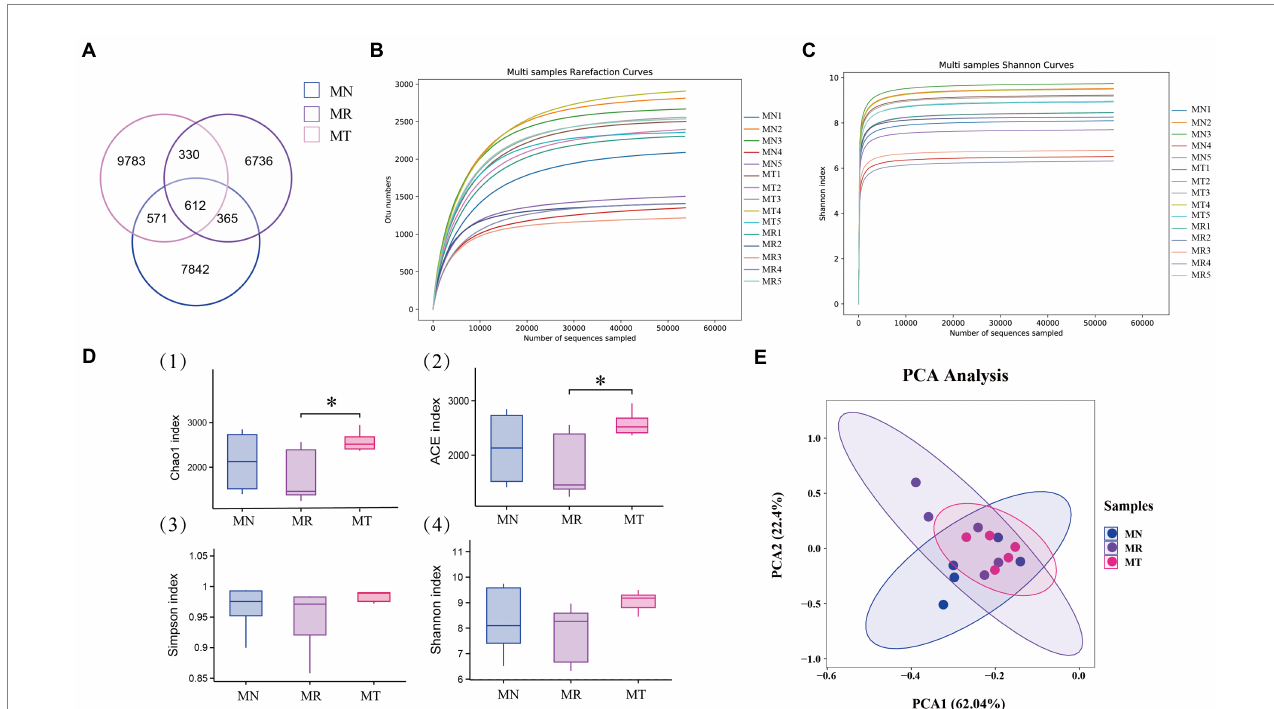
FIGURE 6 Effect of SMD on the number and diversity of bacterial OTUs in the intestinal mucosa of mice with spleen deficiency constipation. (A) Venn diagram: number distribution of OTUs of three groups of intestinal mucosal bacteria. (B) Dilution curve (C) Shannon-Wiener curve. (D) Alpha diversity index (Sharma and Rao, 2017) Chao1. (Milosavljevic et al., 2022) ACE. (Zhao et al., 2022) Simpson. (Tian et al., 2021) Shannon. (E) Principal component